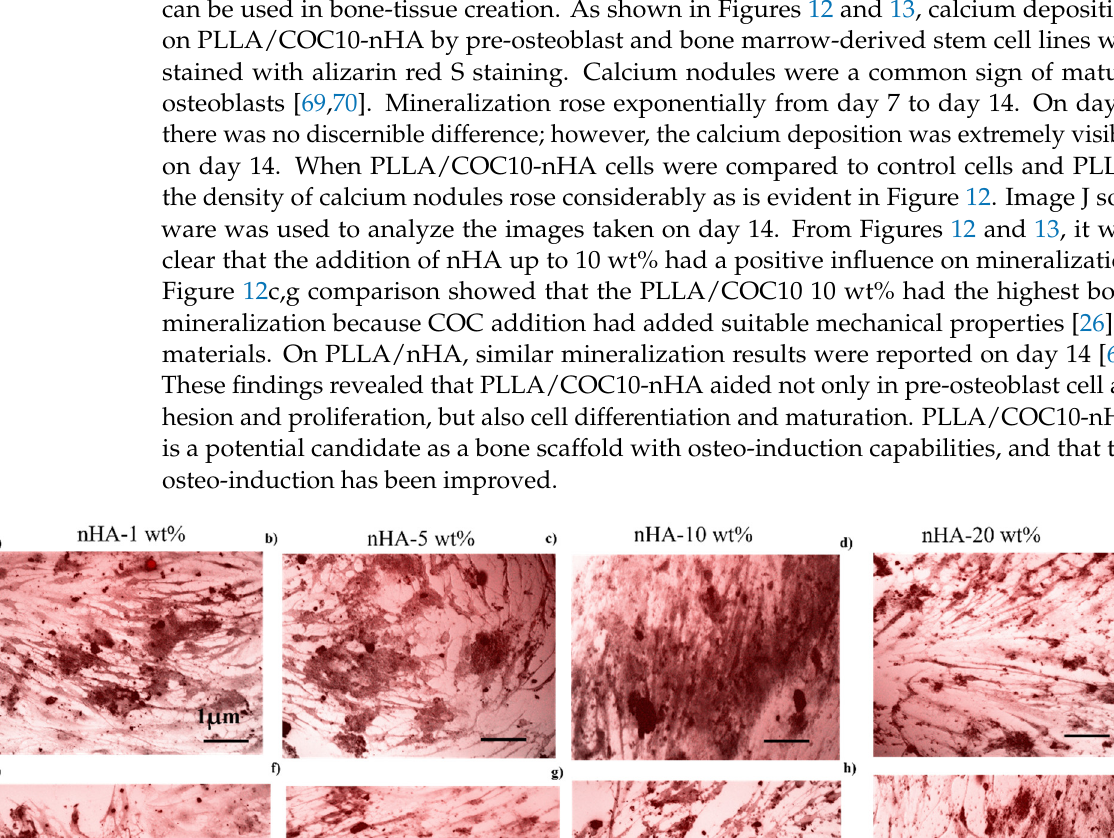
Figure 13. Alizarin red S staining was used to analyze the mineralization of BMSC for PLLA/COC10-nHA ( a – d ) and for PLLA-nHA ( e–f ). BMSC were grown for 14 days, then stained with alizarin red S to identify mineralized nodules after 14 days. Scale bar: 1 μ m in all the images. Nanocomposites had nHA in 1 wt%, 5 wt%, 10 wt%, and 20 wt%. After three different experiments, the data is represented.